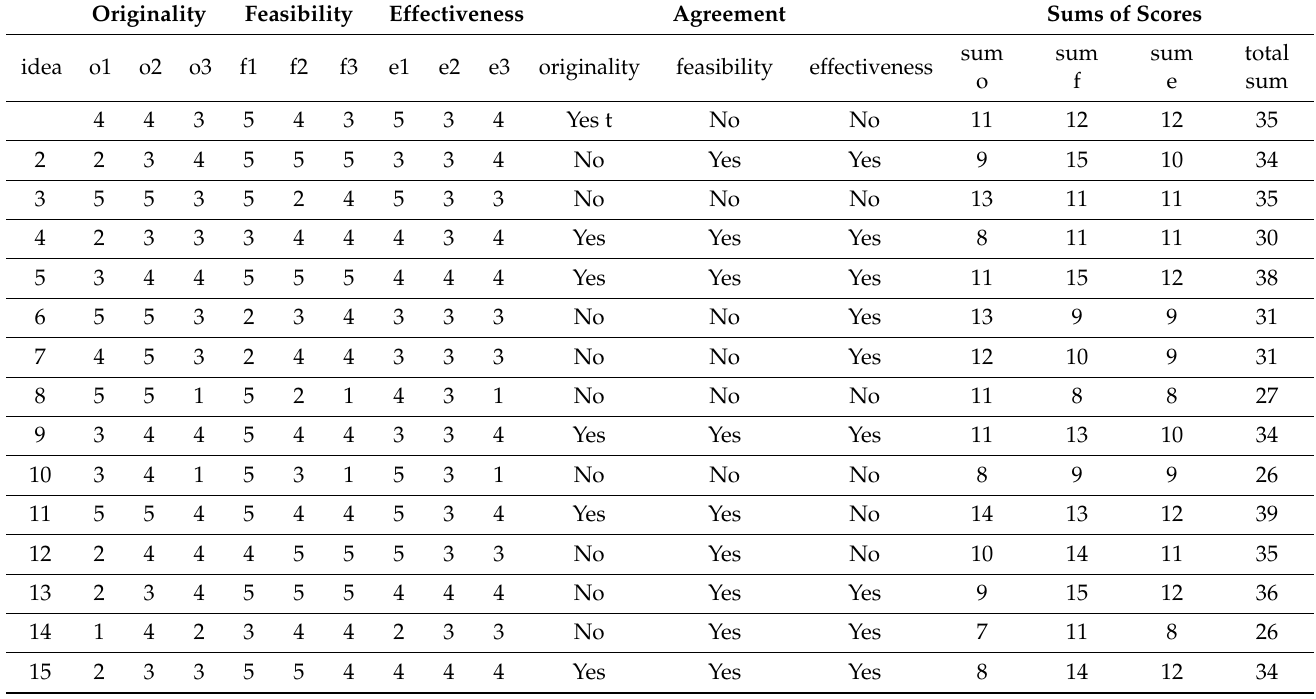
Table A2. Individual scores for each idea by the three judges, records of their agreements, and summary